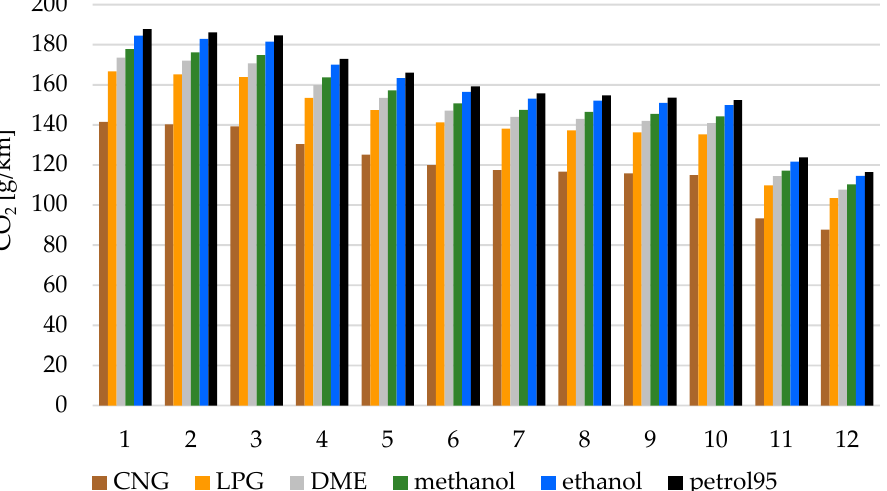
Figure 13. A summary of the carbon dioxide emission in the tests per one kilometer driven: 1—Random cycle high ( × 95); 2—NEDC; 3—US SC03; 4—CADC wo mot; 5—Random Cycle Low ( × 05); 6—WLTC 3b random; 7—FTP-75; 8—CADC; 9—US 06; 10—CADC shortened; 11—MAC TP cycle; 12—US highway.